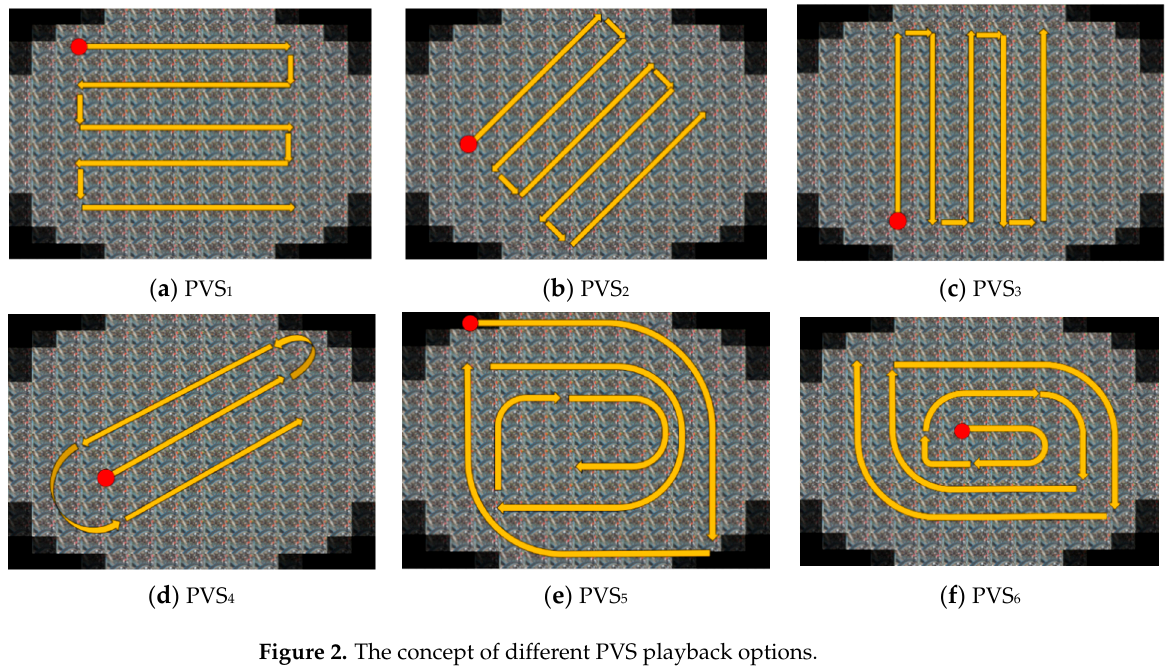
Figure 2. The concept of different PVS playback options.